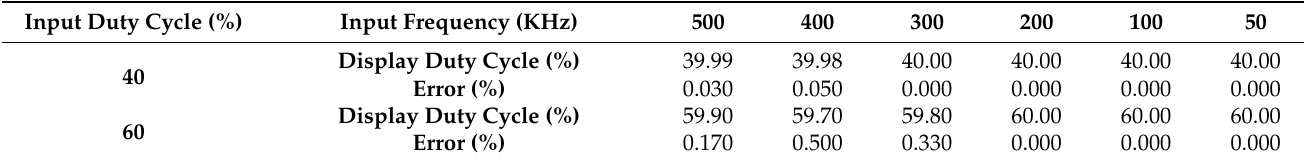
Table 3. Duty cycle test.